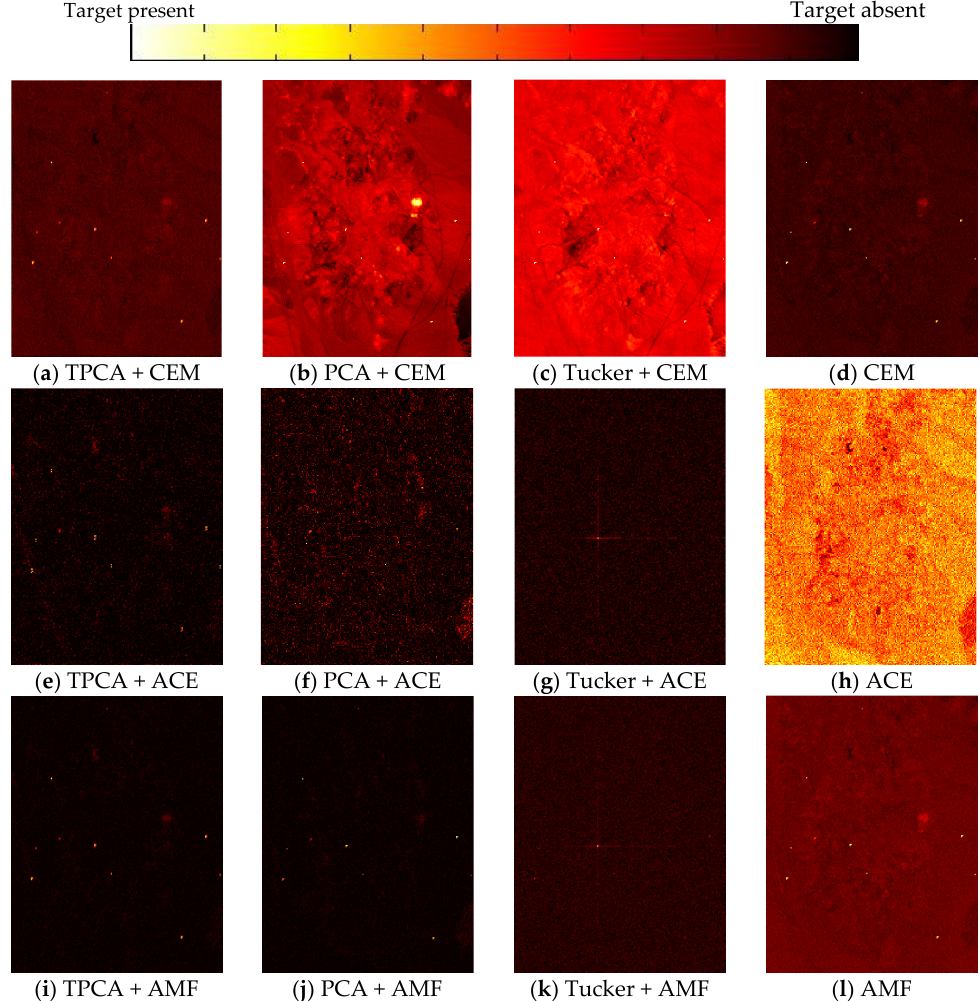
Figure 8. Detection results of the synthetic dataset with different feature extraction methods and traditional TD methods.